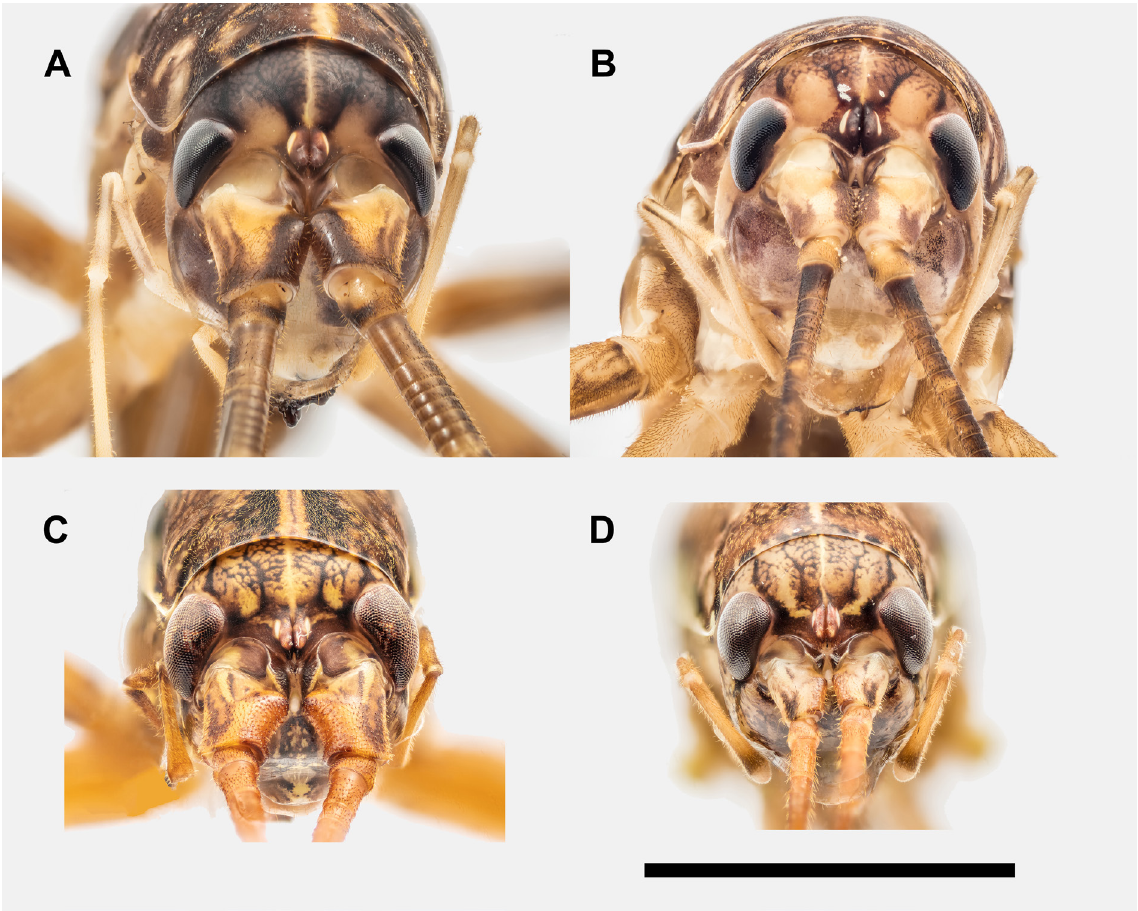
Fig. 4. Head of cave wētā in the genus Pleioplectron Hutton, 1896 showing sexual dimorphism. A–B . P. simplex Hutton, 1896. A . Adult ♂, Hinewai Reserve, Banks Peninsula (MPN CW4118). B . Adult ♀, Helicopter Hill Track, Craigieburn (MPN CW3914). C–D . P. crystallae sp. nov. C . Adult ♂, Branch Creek Hut, Mt Owen (MPN CW4271). D . Adult ♀, Salisbury Lodge, Mt Arthur Tablelands (MPN CW3941). Scale bar = 5